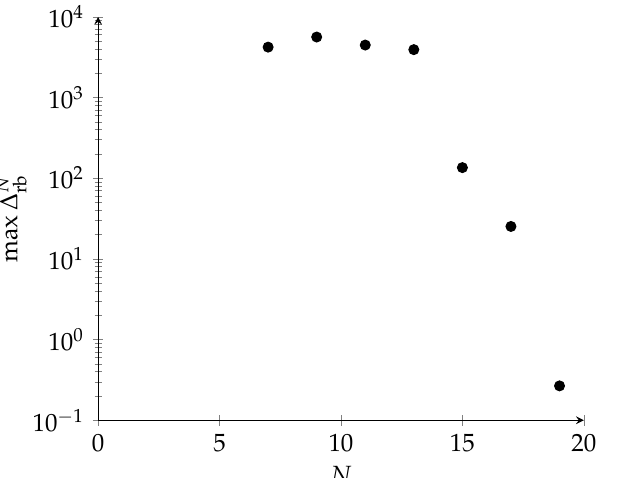
∆ N = max ( µ ) during the µ ∈ Ξ rb rb